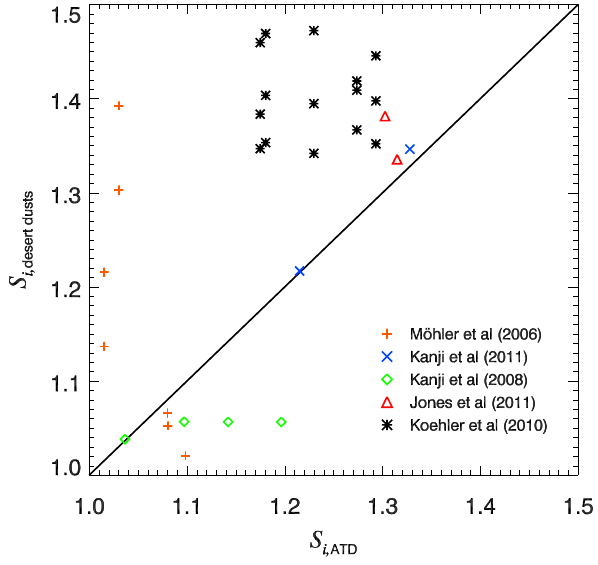
Fig. 8. Saturation ratios at nucleation onset for Arizona test dust and natural desert dusts (Saharan, Asian, Canary Island and Owens Lake dust) under comparable experimental conditions and interpo- lated to the same temperatures, respectively. The data by Koehler et al. (2010) are for dry dispersed particles of 200nm size. The data by Kanji et al. (2011) are for UT-CFDC measurements sam- pled from the aerosol preparation and characterization chamber for ATD and Canary Island dust, which have similar size distributions. The data by Kanji et al. (2008) are interpolated to the same total particle surface areas. The data by Jones et al. (2011) are from the CSU-CFDC instrument and for water-subsaturated conditions.